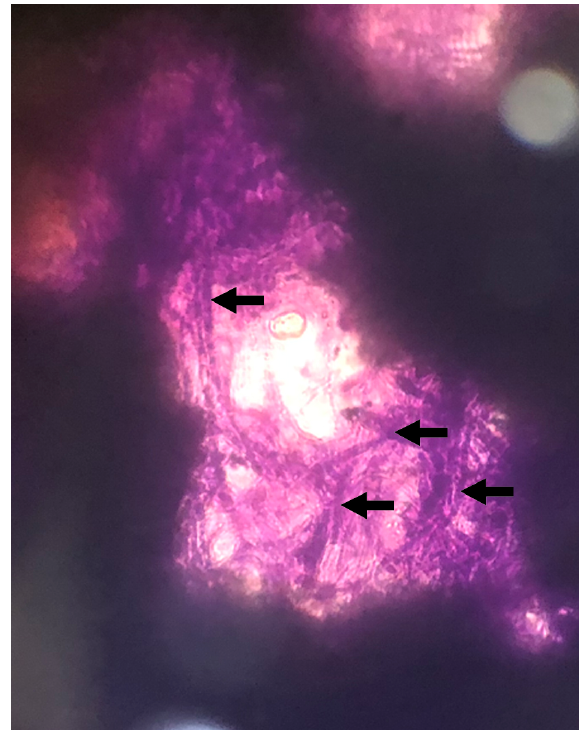
Figure 2: Giemsa stain of scrapings obtained from the corneal plaque showing an extensive amount of hyphal elements (black arrows).